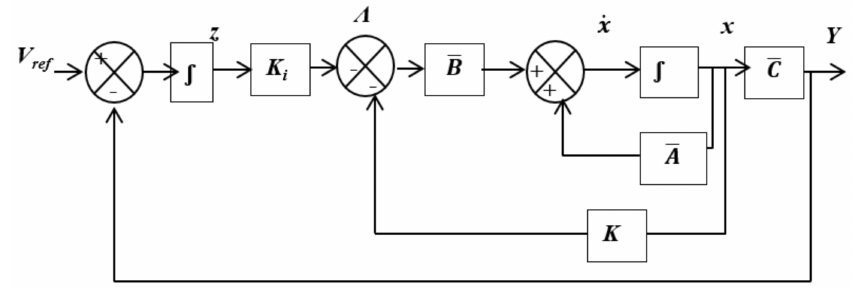
Figure 10. Block diagram representation of multivariable LQR